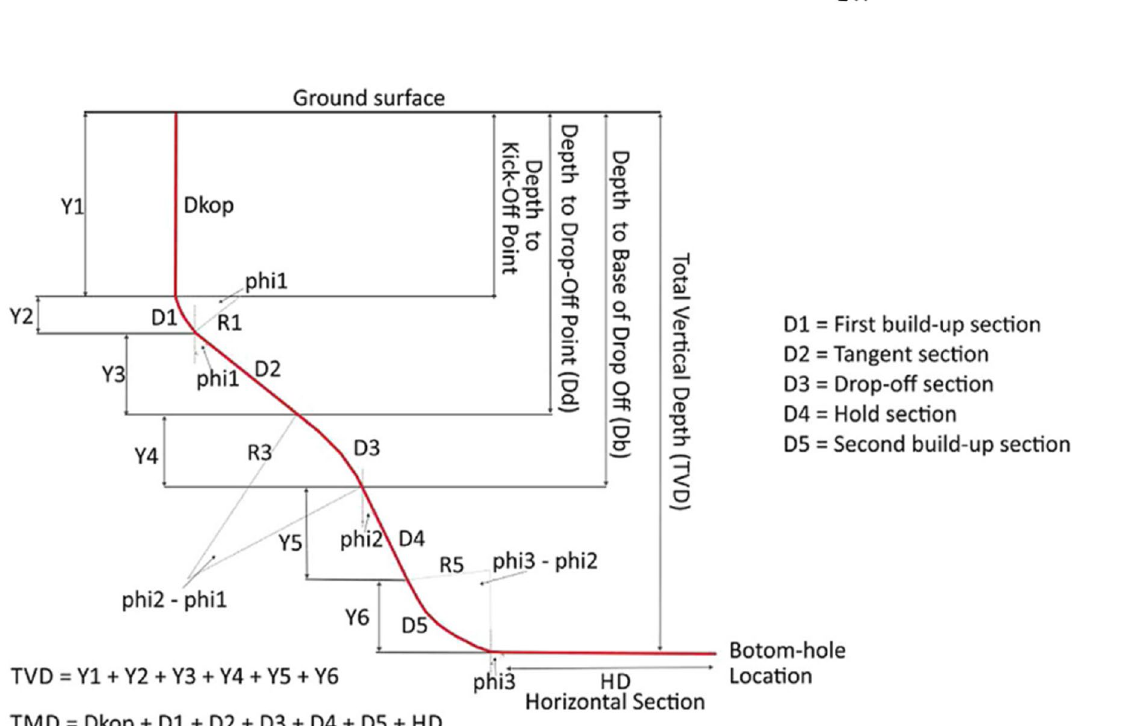
Fig. 3 The vertical plane of a horizontal well (second case study) with the operational parameters from Atashnezhad et al. (2014) developed from the wellbore scenario studied originally by Shokir et al. (2004). Note that the scenario involves more than one build sec-